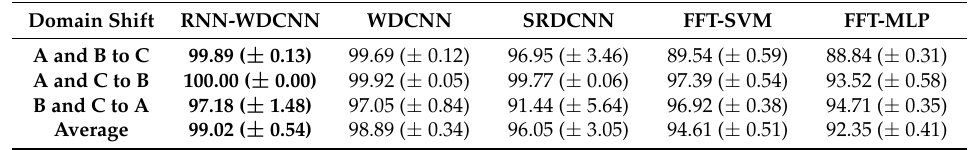
Figure 10. Domain adaptation accuracy comparison between RNN-WDCNN and WDCNN, SRDCNN, and FFT-based methods for scenario 2 (best values are highlighted in bold). Table 10. Precision scores of the models considered in this work (as a percentage) for the domain adaptation task considered in scenario 2 (best values are highlighted in bold).